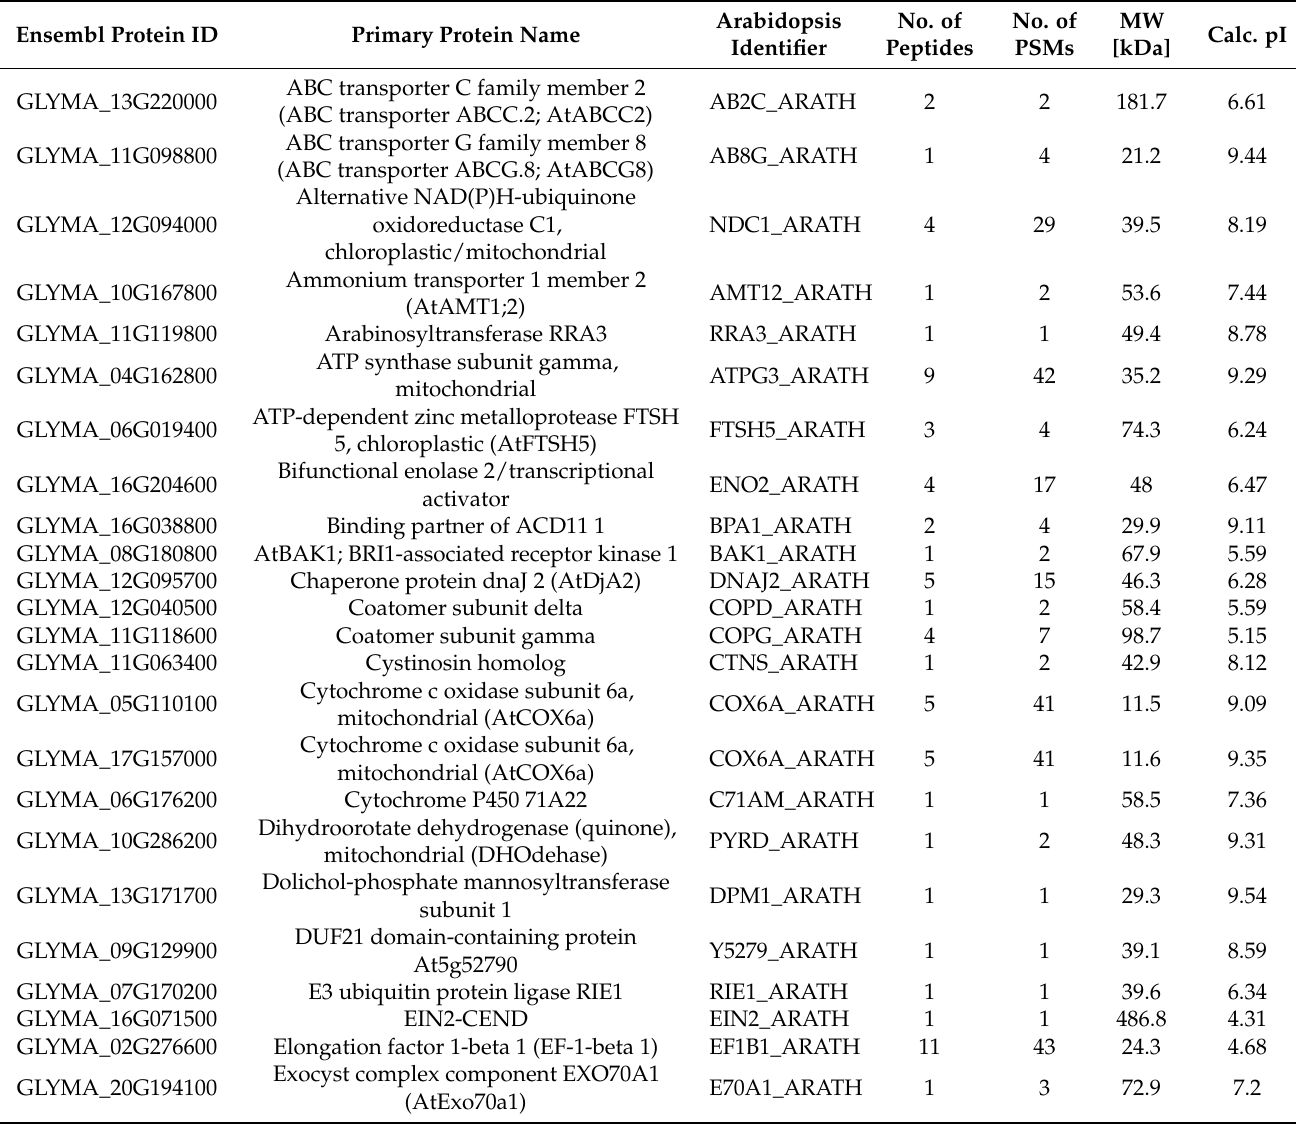
Table 6. Salt-stress-inducible membrane proteins in soybean